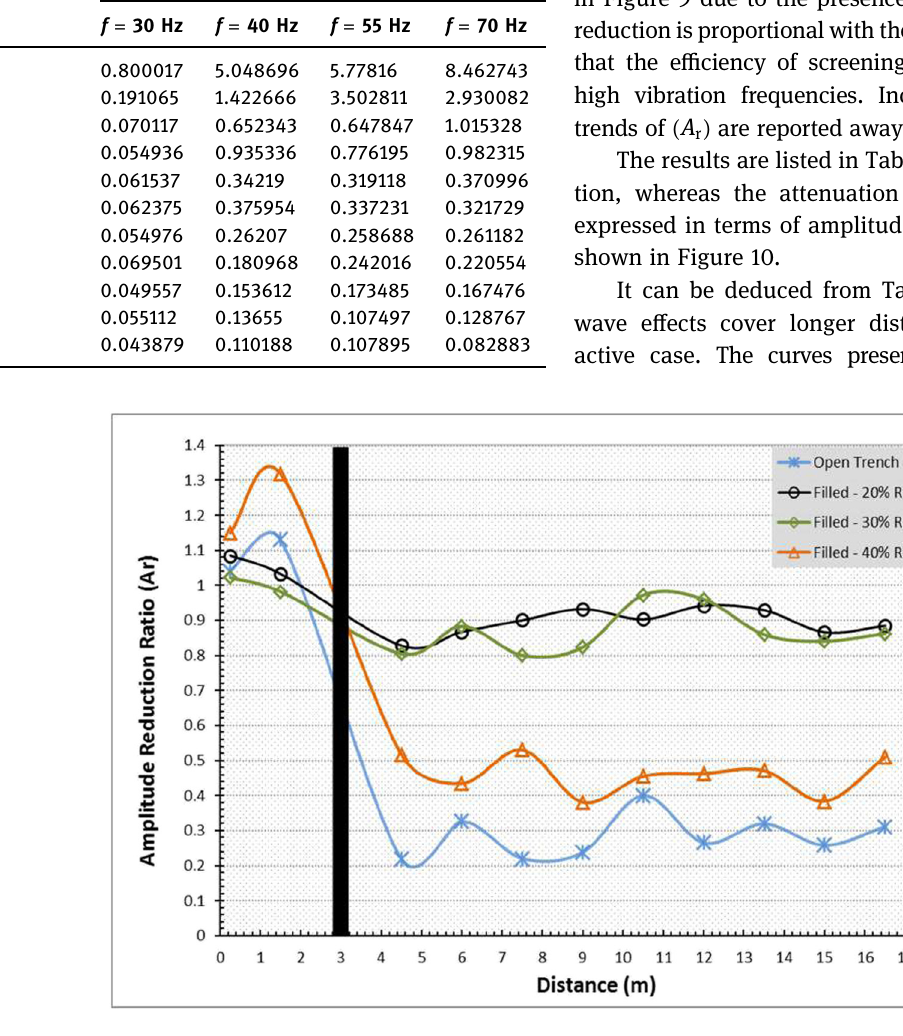
Figure 14: Attenuation of vibration due to active trench barriers ( f 30 Hz = ) .